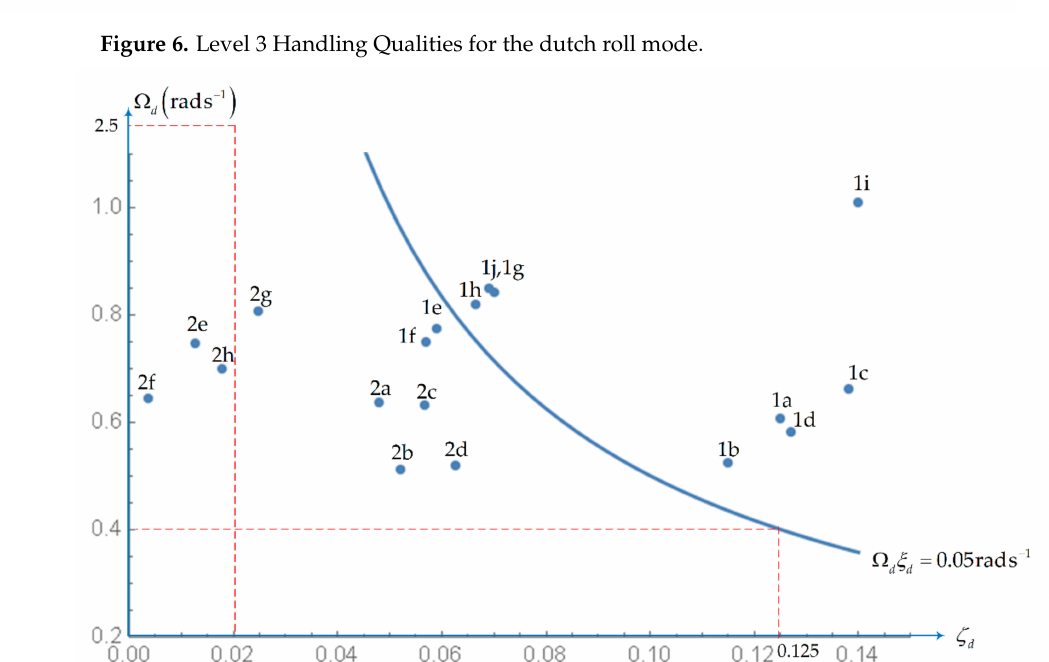
Figure 7. Level 2 Handling Qualities for the dutch roll